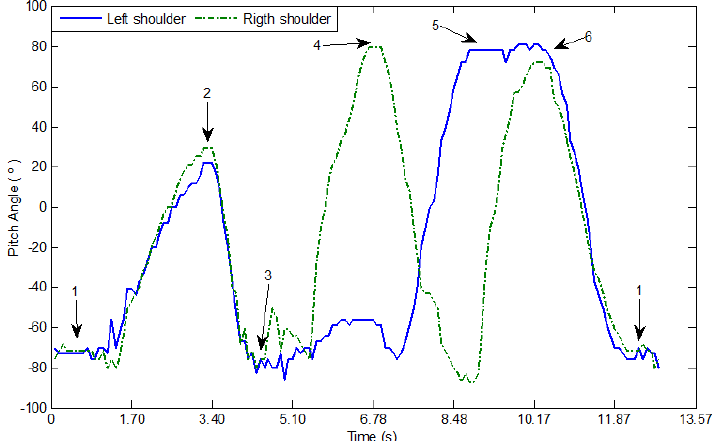
Figure 13. Angular measurement of the rotation of sagittal plane on the left and right shoulders when the teleoperator is moving the arms up and